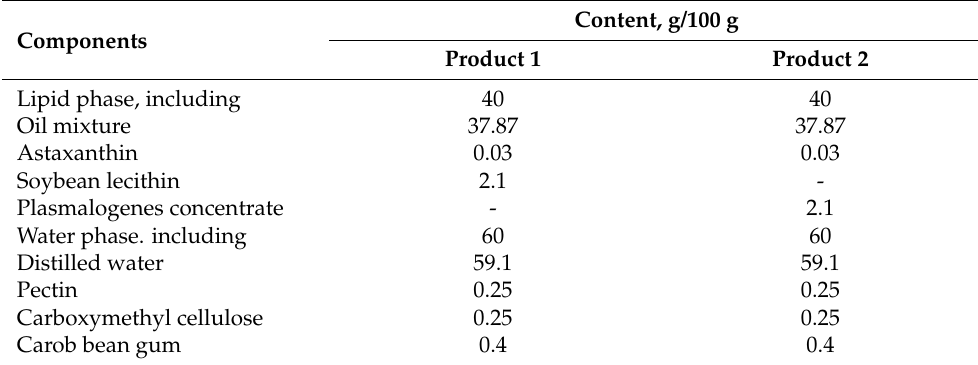
Table 4. Composition of the developed functional